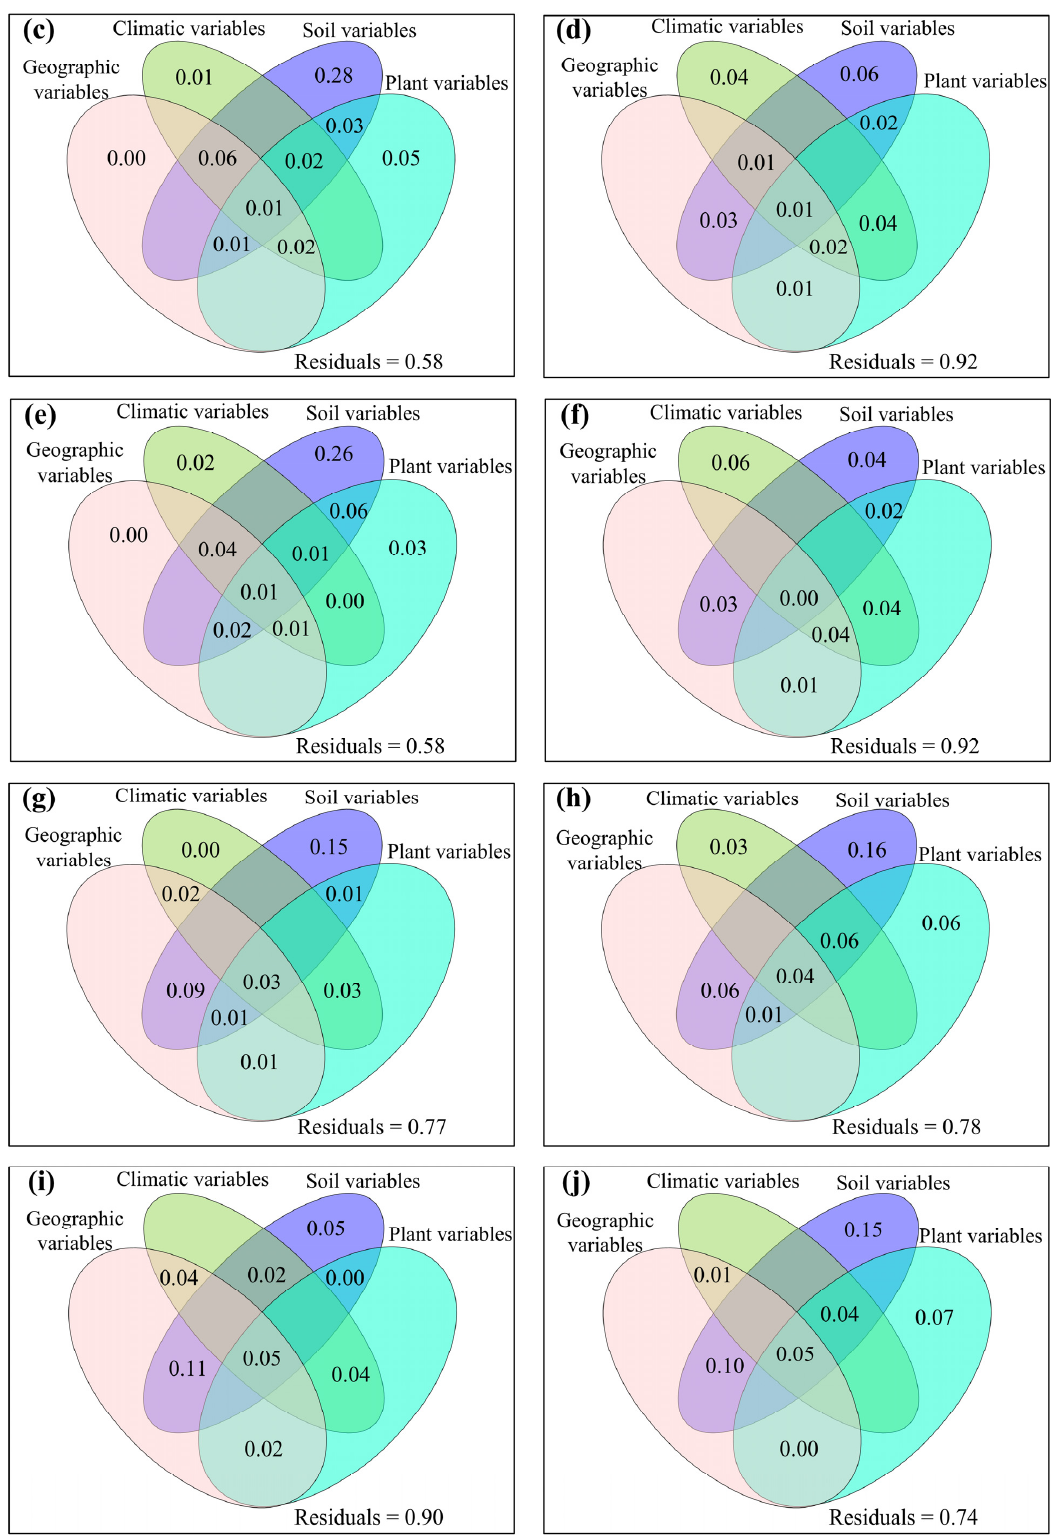
Figure 8. The mutual as well as excluded impacts of geographic variables, climatic variables, soil variables and plant variables on ( a , b ) guild numbers, ( c , d ) Chao1 f , ( e , f ) ACE f , ( g , h ) Shannon f and ( i , j ) Simpson f of soil fungal community for ( a , c , e , g , i ) topsoil and ( b , d , f , h , j ) subtopsoil,